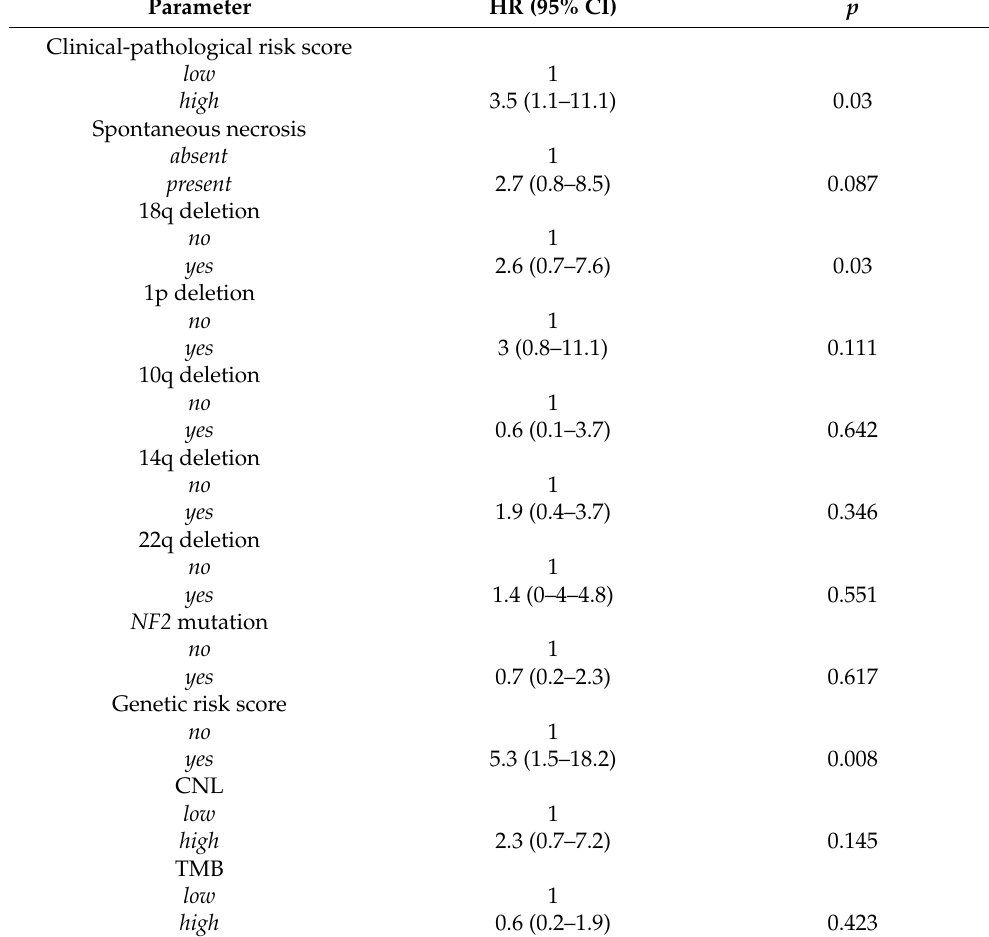
Table 2. Univariate analyses for recurrence-free survival (RFS) in 22 patients with atypical meningiomas. Parameter HR (95% CI) p Clinical-pathological risk